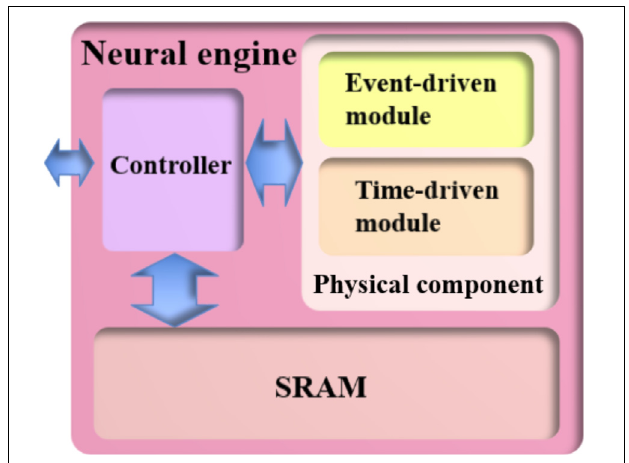
FIGURE 3 | A naïve implementation of the neural engine. The physical component computes the data for one virtual component module in one clock cycle. The controller provides the physical component with its input data, which is read from the SRAM, and writes the computed output data to the